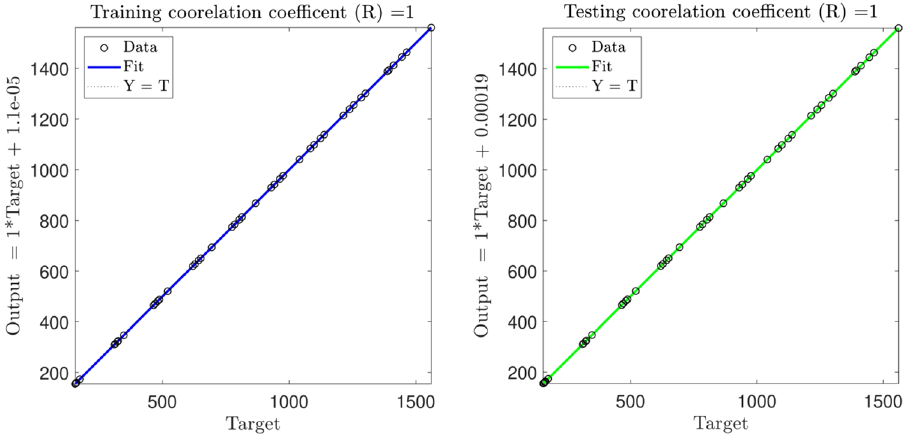
Figure 7. The plot of regression for the best intelligence. The number of inputs = 5. MF is guass2mf.